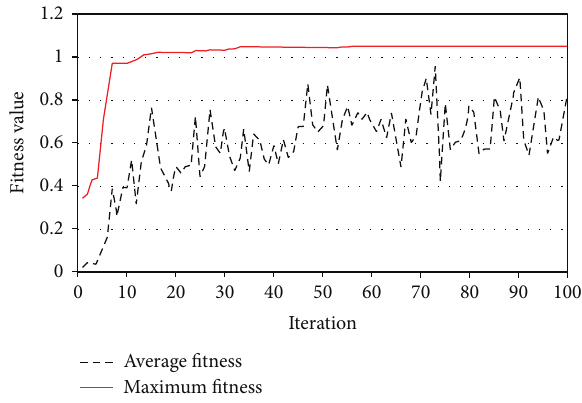
Figure 18: Fitness values versus iterations in example problem 2.